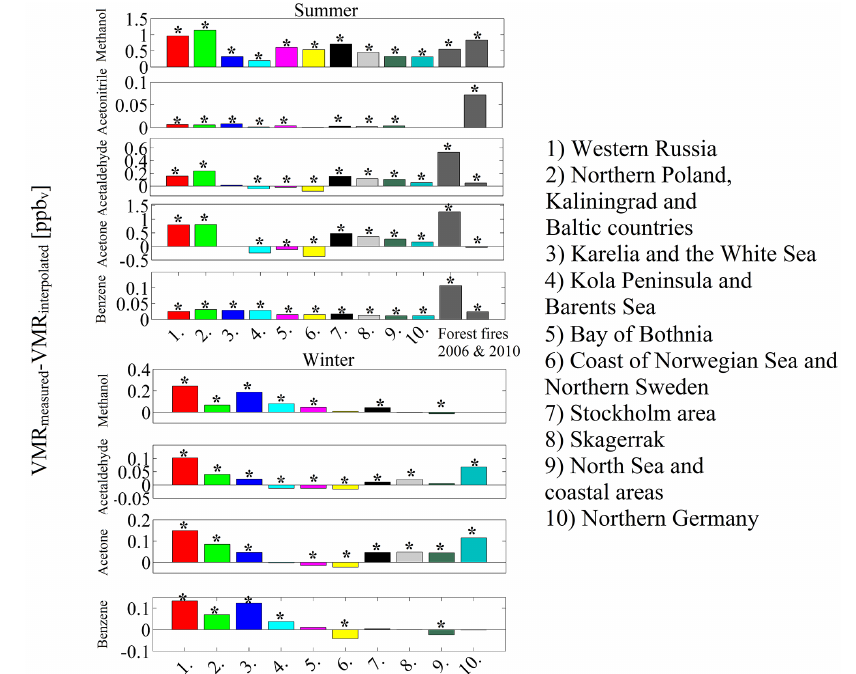
Figure 7. Differential source fields VMR measured -VMR interpolated (ppb v ) Hourly VMR values of source areas interpolated from monthly medians were subtracted from directly measured hourly values of source areas during summer (upper panel) and during winter (lower panel) for methanol ( m 33), (acetonitrile ( m 42), in summer only), acetaldehyde ( m 45), acetone ( m 59) and benzene ( m 79). Forest fire data were removed from summer data and analyzed separately. Asterisk indicates when differential VMR fields of a trace gases differ significantly from zero (two-sided t test).